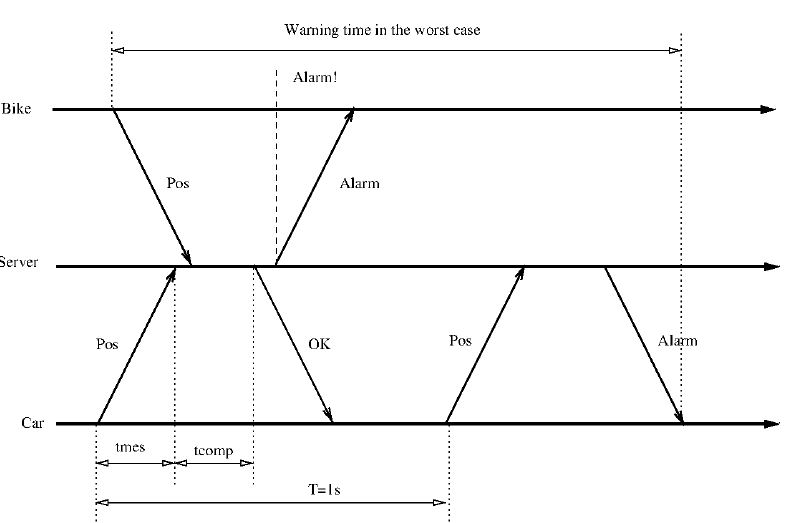
Figure 2. Worst case situation to receive a proximity warning: the server receives the position update from the bike just when it has started to process the car position update looking for alarms. It is possible that the recent message from the bicycle is not taken into account, causing the alarm to be delayed until the next message is